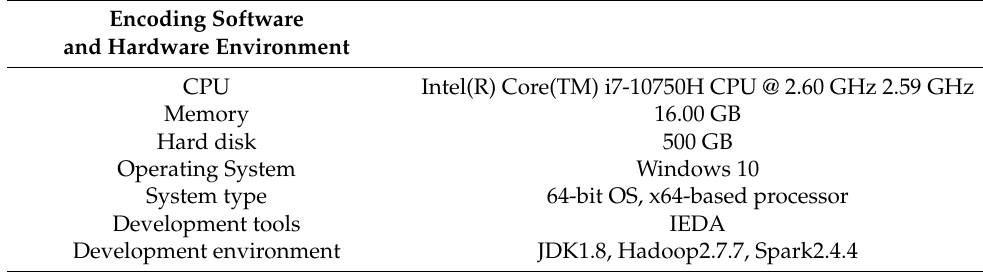
Table 6. Coding environment description.